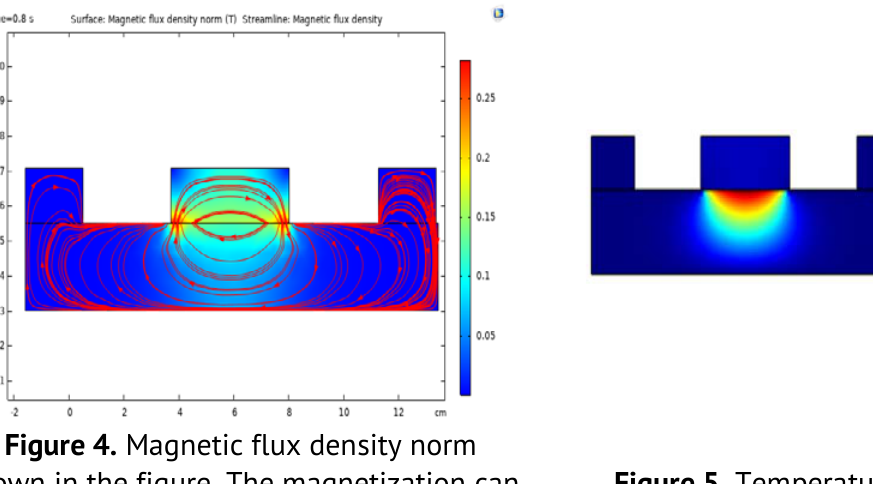
Figure 5. Temperature profile AMR .